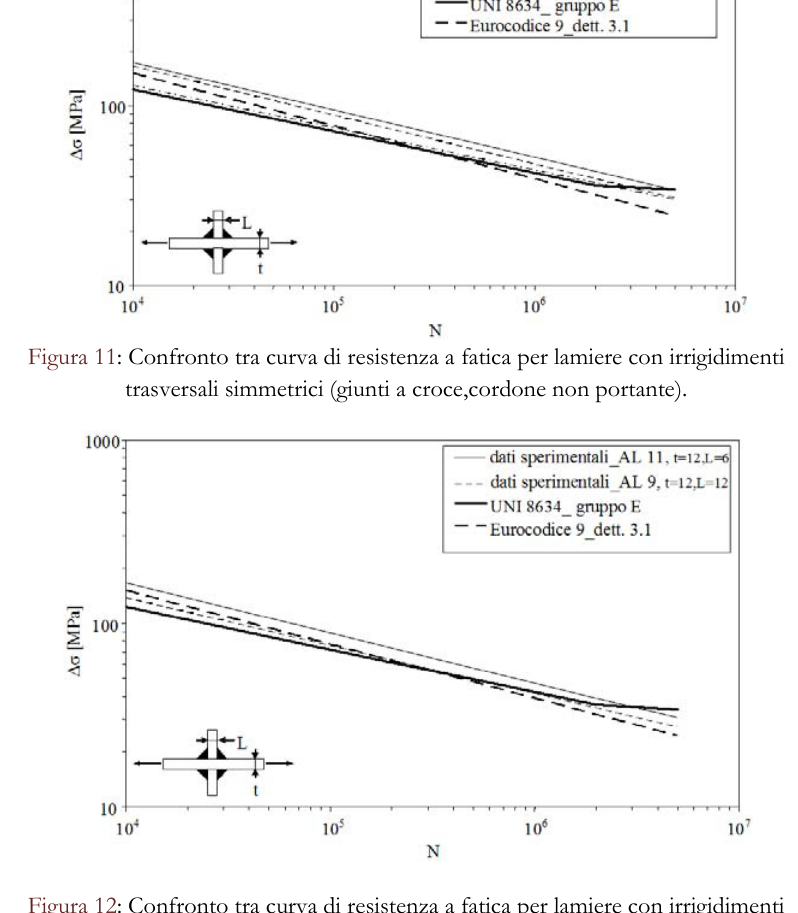
Figura 12: Confronto tra curva di resistenza a fatica per lamiere con irrigidimenti trasversali simmetrici (giunti a croce,cordone non